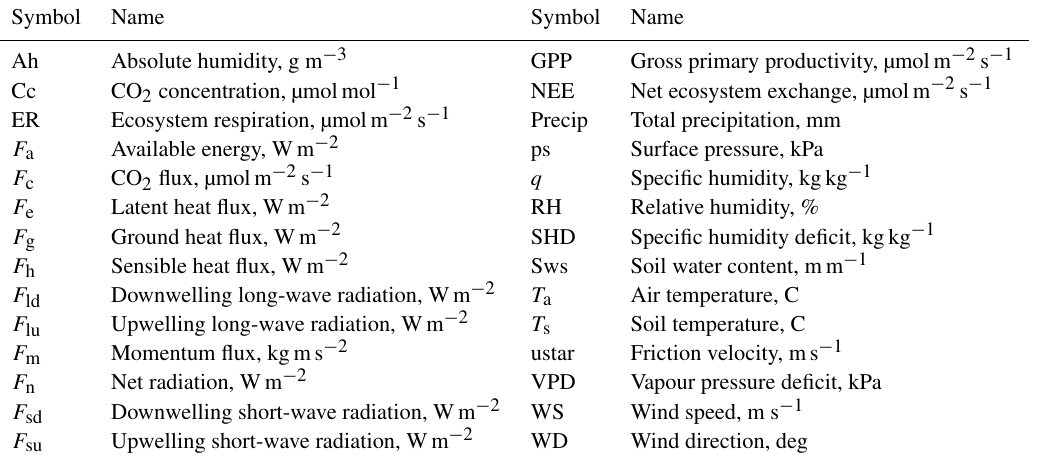
Table A1. This table presents a list of the symbols and names used for the main variables in the OzFlux tower